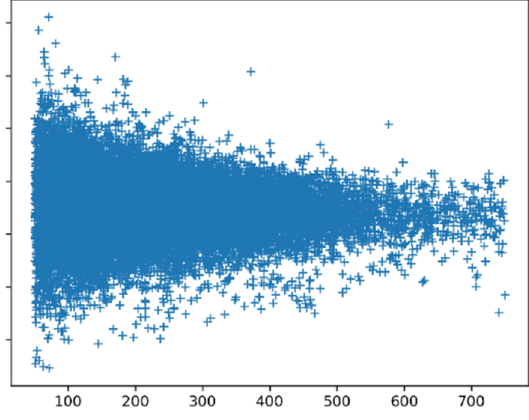
Figure 8. SSN scores as function of protein length.